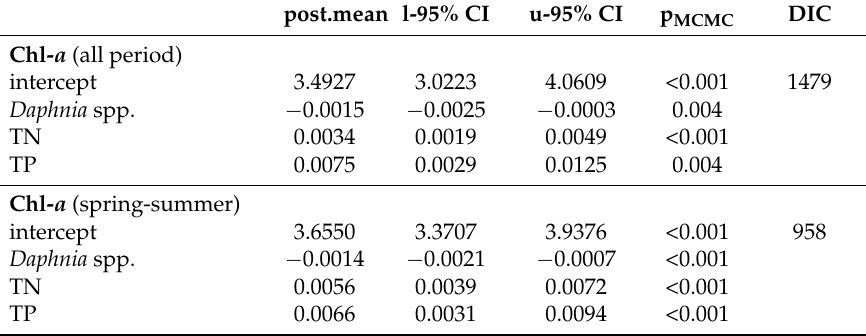
Table 3. Multiple GLMMs based on Markov chain Monte Carlo method showing the predictors for chlorophyll- a concentrations (Chl- a ) during the entire study period and the spring–summer period. The mean of the posterior distribution (post.mean), lower and upper 95% credible interval (l-95% CI and u-95% CI), the MCMC p-value (p MCMC ) and deviance information criterion (DIC) are reported. post.mean l-95% CI u-95% CI p